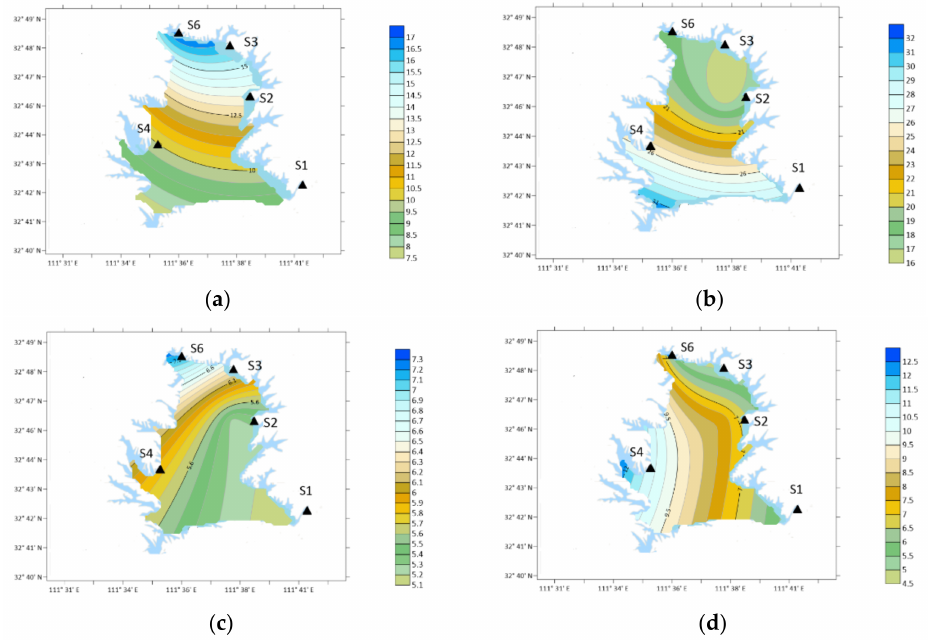
Figure 13. Spatial variation of 2-ELA concentration. ( a ) Winter; ( b ) spring; ( c ) summer; ( d )